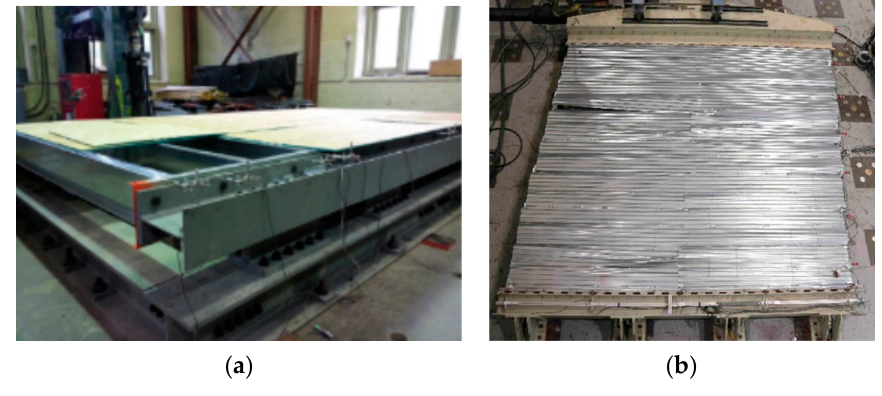
Figure 10. ( a ) Wood-sheathed diaphragm specimen [36]; ( b ) steel deck diaphragm specimen [37].